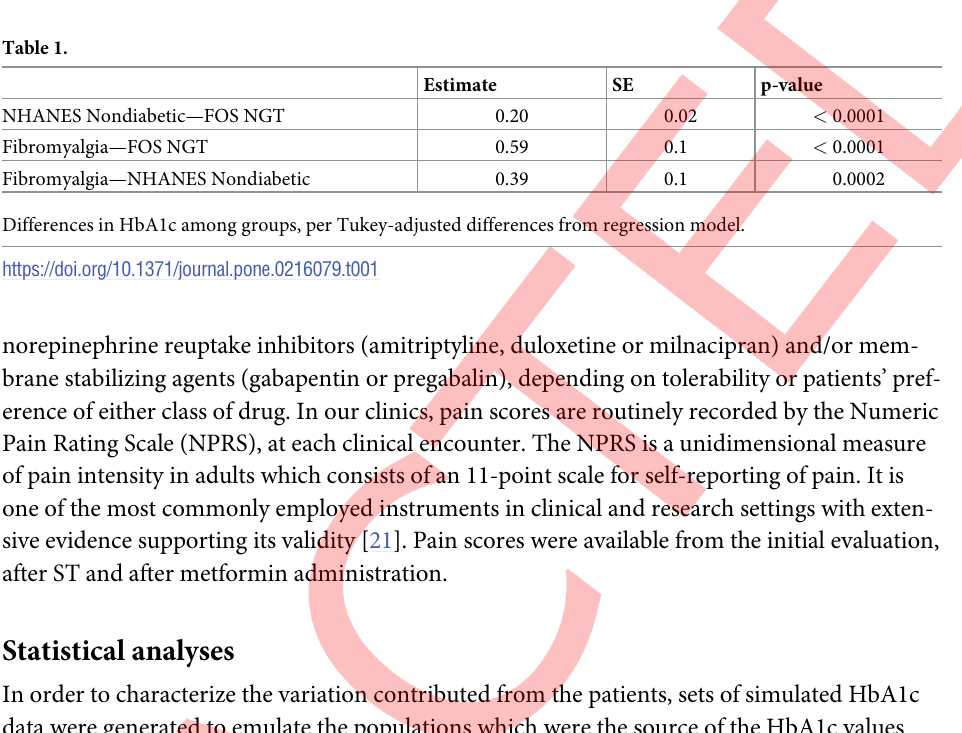
Estimate SE p-value